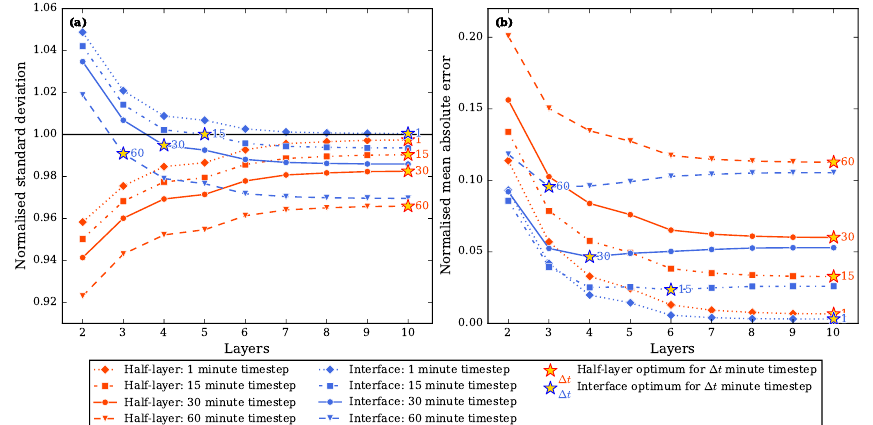
Figure D1. Mean heat storage errors of the half-layer and the proposed interface schemes vs exact solutions over 2–10 layer representations and for 1, 15, 30 and 60min time steps (per Fig. 2). For both (a) normalised standard deviation and (b) normalised mean absolute error, the interface scheme outperforms the half-layer scheme on average for the 288 representations of walls/roofs based on the CLMU database (Jackson et al., 2010). Optimum number of layers for each time step is identified with a star. The margin of improvement of the interface scheme is greatest at low time and space